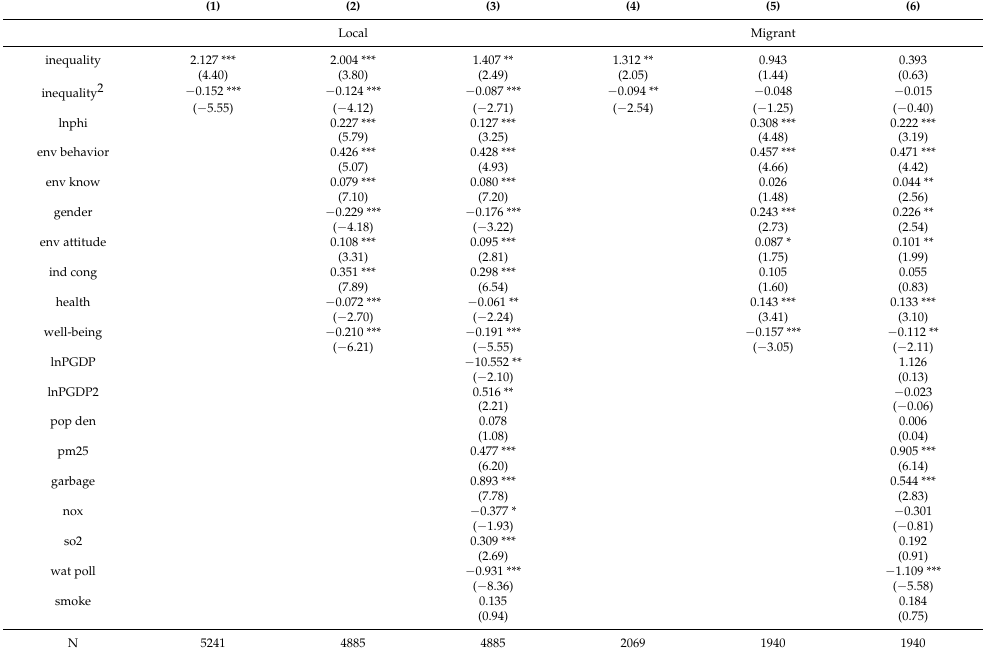
Table A10. The effect of individual-level income inequality on subjective environmental pollution: differences between the locals and